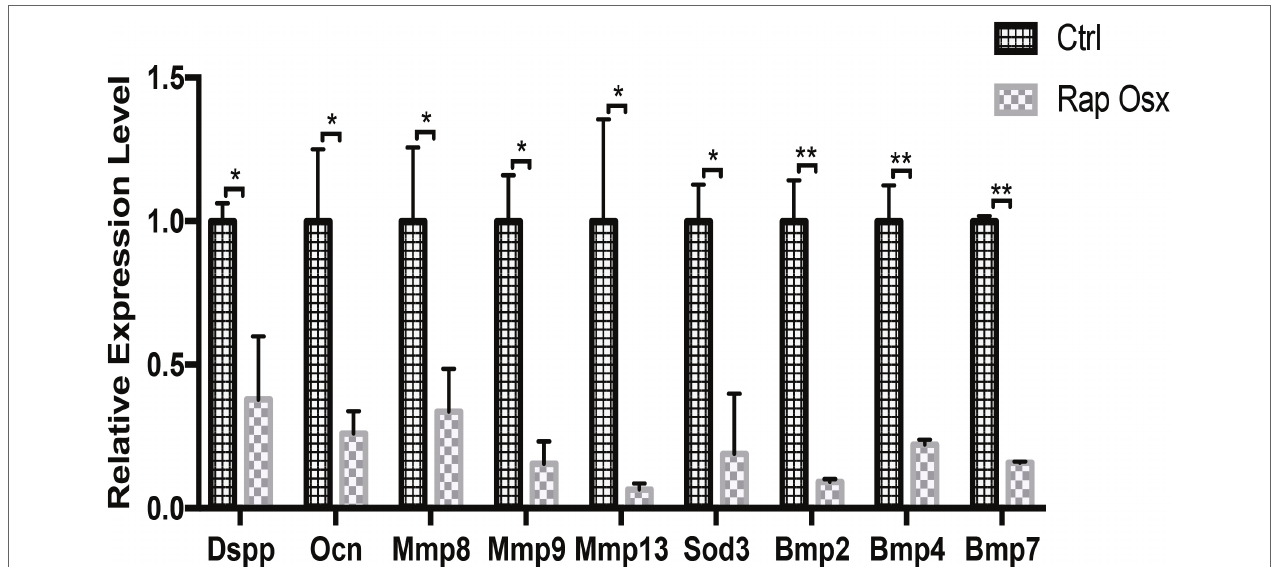
FIGURE 4 | Expression levels of selected genes were validated by qPCR (* p < 0.05, ** p <